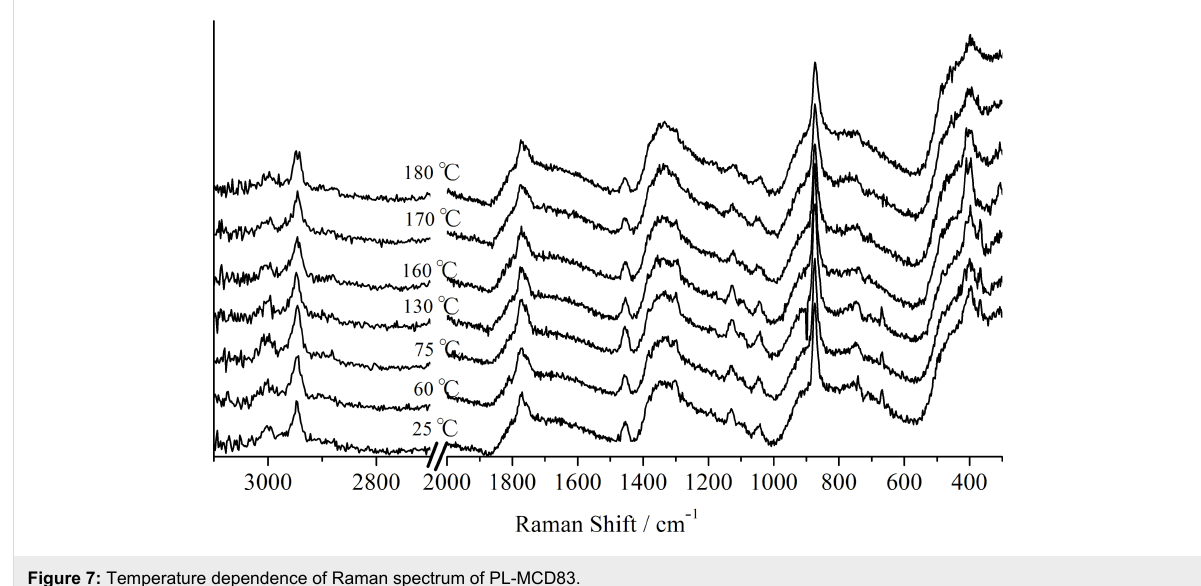
Figure 7: Temperature dependence of Raman spectrum of PL-MCD83.